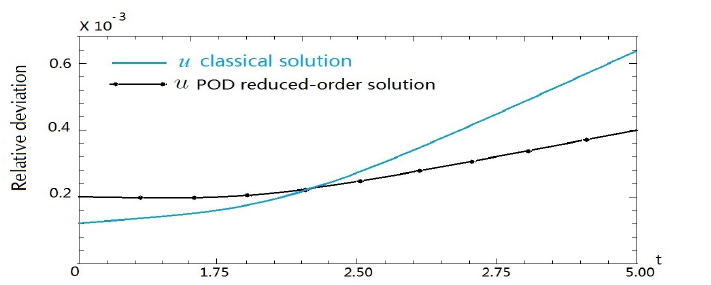
Figure 10. The relative deviations of the classical SCNMFE solution and the POD-based reduced-order SCNMFE solution with 6 POD bases of velocity u for Re = 1000 on 0 (cid:54) t (cid:54) 5.